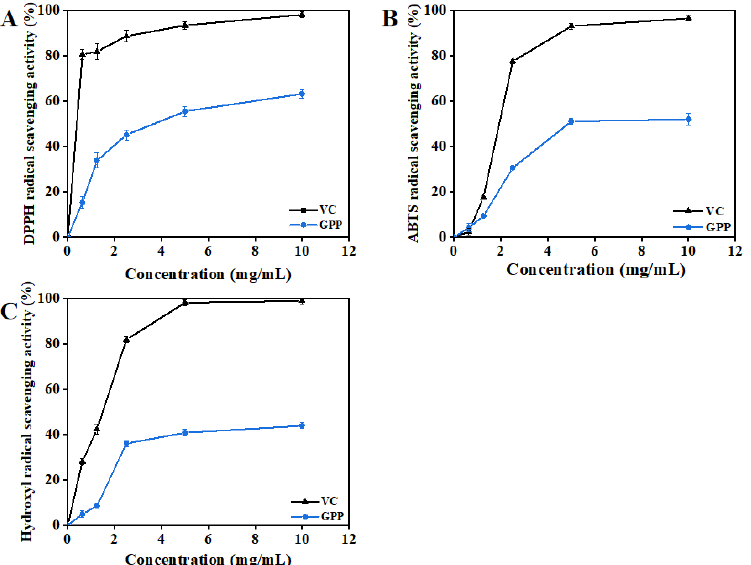
Figure 3. Antioxidant activity of grape pomace polysaccharides. ( A ) DPPH radical scavenging ca- pacity, ( B ) ABTS radical scavenging capacity and ( C ) OH - scavenging capacity. All treatments were performed in triplicate, and data are shown as means ± standard deviations. Ascorbic acid was the positive control.